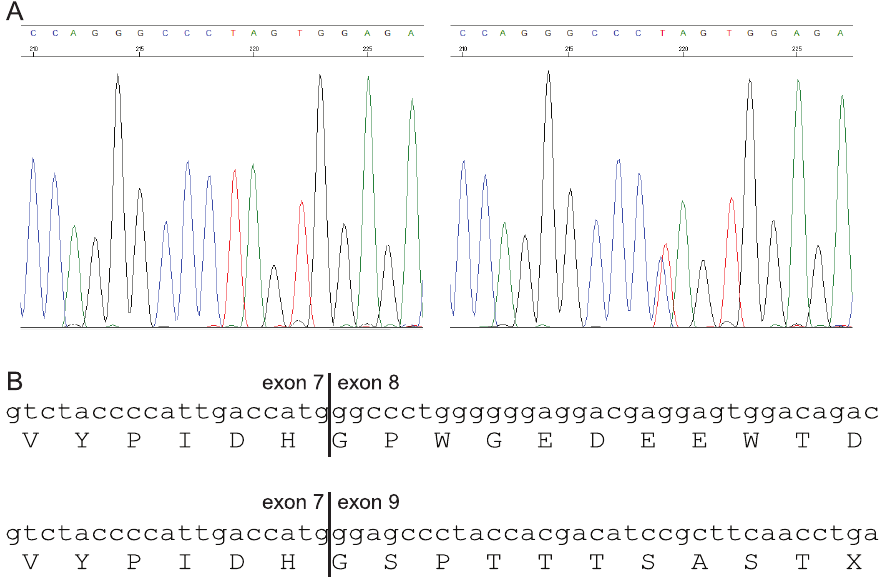
Figure 2. Sanger sequencing trace and amino acid alignment showing the truncated BAP1 protein. (A) The left panel shows the wild type chromatogram while the right panel shows that of the BAP1 splice mutation. (B) Wild type nucleotide and amino acid sequences are shown in the upper panel while the lower panel shows part of the truncated BAP1 protein resulting from the loss of exon 8.